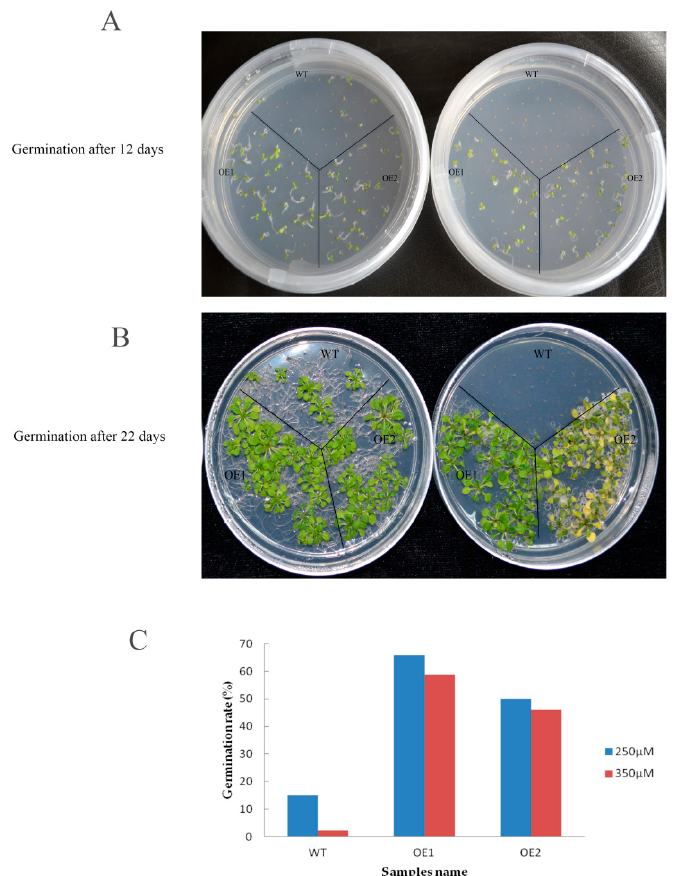
Figure 10. The germination of transgenic Arabidopsis and wild type (WT) under Cd stress. ( A ) 12 days of seed germination of transgenic Arabidopsis thaliana plants and WT; ( B ) 22 days of seed germination of transgenic Arabidopsis thaliana plants and WT. ( C ) The germination rate of transgenic Arabidopsis thaliana plants and WT under 250 and 350 µ M Cd stress for 22 days. WT represents the wild Arabidopsis thaliana . OE1 and OE2 represent the transgenic Arabidopsis thaliana . Transgenic plants and WT seeds grew on 1/2 MS solid medium containing 25, 50 and 100 µ M Cd solution for 12 days (Figure 11). There was no difference in root length between transgenic seedlings and WT plants under 25 µ M Cd stress, while under 50 µ M and 100 µ M Cd stress, the root length of transgenic seedlings was significantly longer than WT plants. These results indicate that overexpression of GhHMAD5 gene can enhance the Cd tolerance of transgenic Arabidopsis thaliana